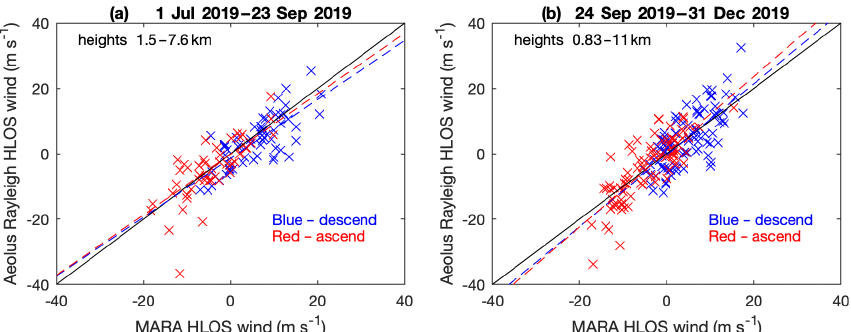
Figure 3. Scatter plots of Aeolus Rayleigh HLOS winds against HLOS winds according to MARA radar data. Red crosses indicate mea- surements made on ascending tracks and blue crosses are used for descending tracks. Dashed red and blue lines show fitted regression lines. Black dashed line indicates equality. Heights indicated are the lowest and highest where valid winds are available for comparison. (a) The